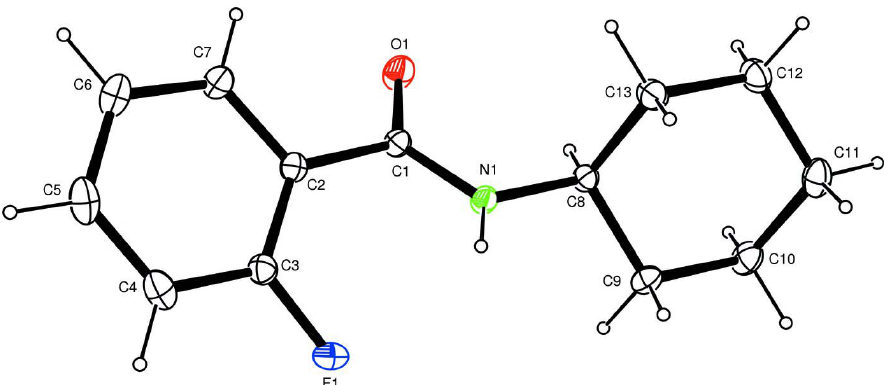
Figure 1 The structure of (I) with displacement ellipsoids for the non-hydrogen atoms drawn at the 50% probability level.